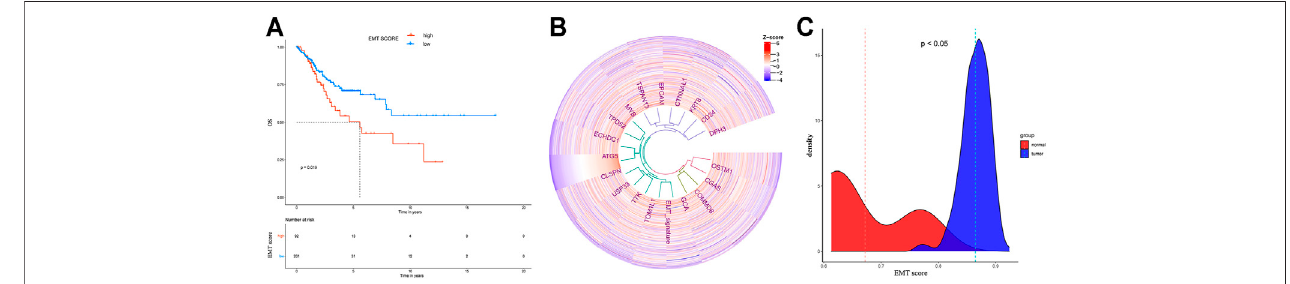
FIGURE 5 | The correlation between ATG5 and co-expressed genes involved in the regulation of EMT in cervical cancer patients. A. the Kaplan-Meier survival plot showed that the median OS time of low EMT score patients was signi fi cant longer than high EMT score patients. B. ATG5 showed co-expressed ship with genes involved in the regulation of EMT in cervical cancer patients. C. The EMT signature showed signi fi cant difference in cervical normal and cancer tissues.